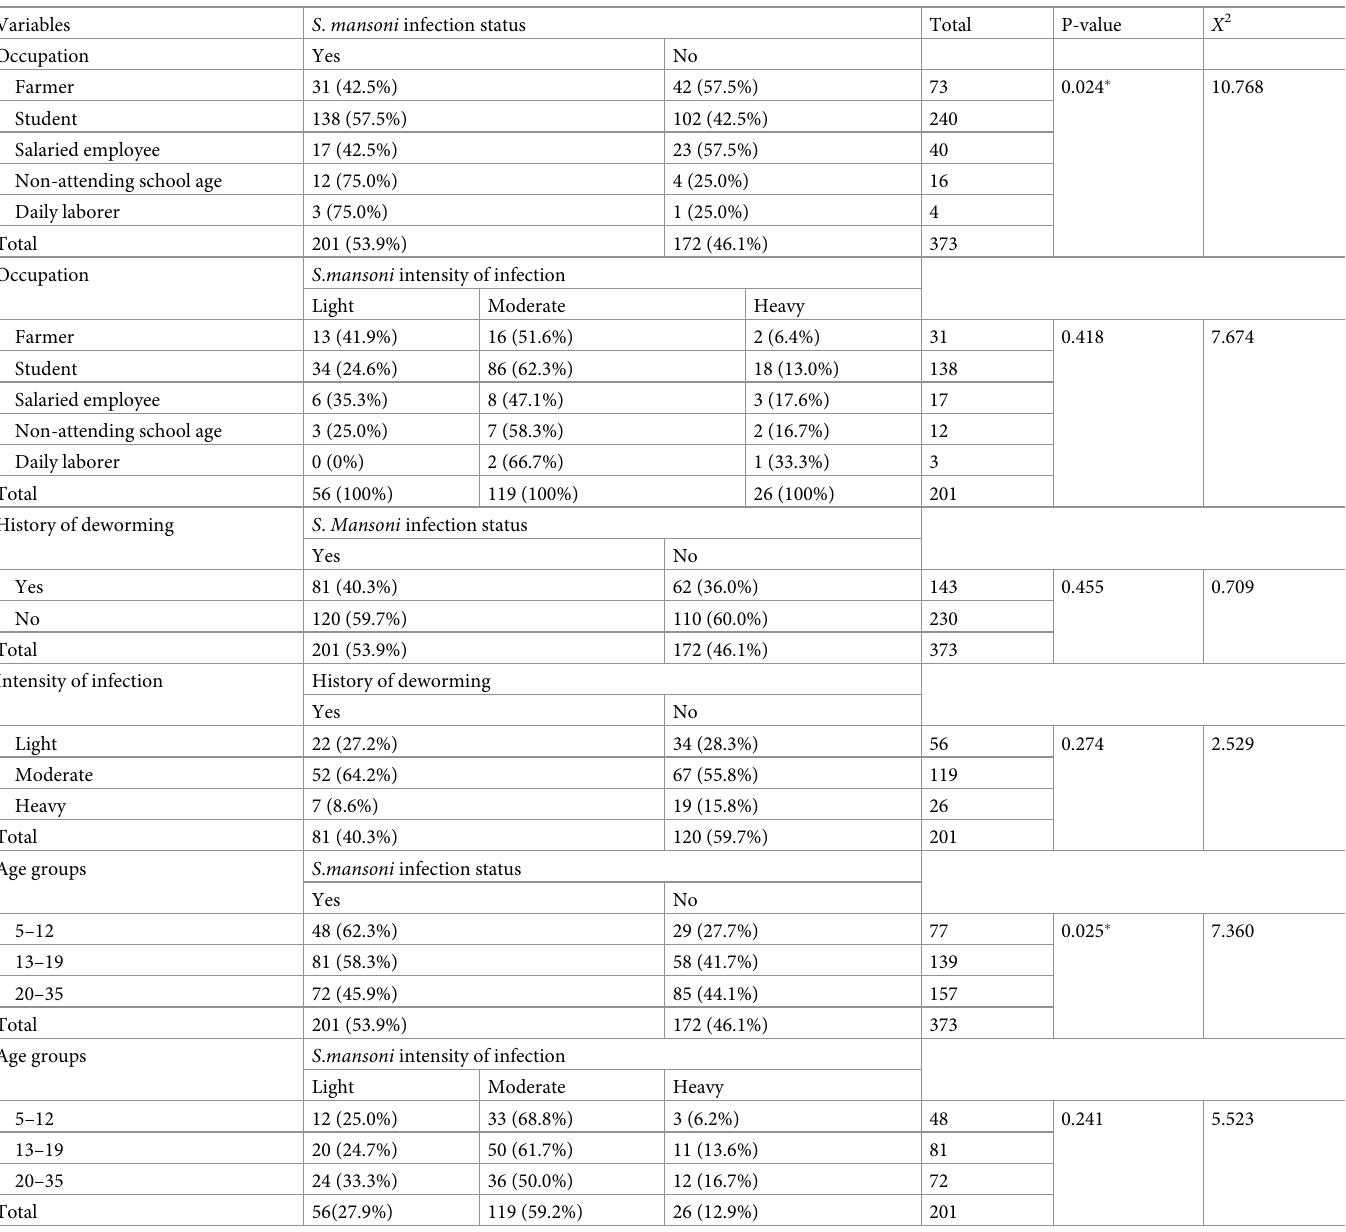
Table 2. S . mansoni infection status and intensity of infection and associated